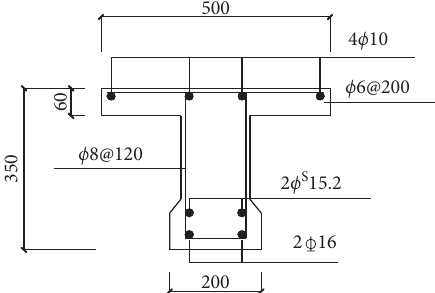
Figure 1: Section dimension and reinforcement of test beams (unit: